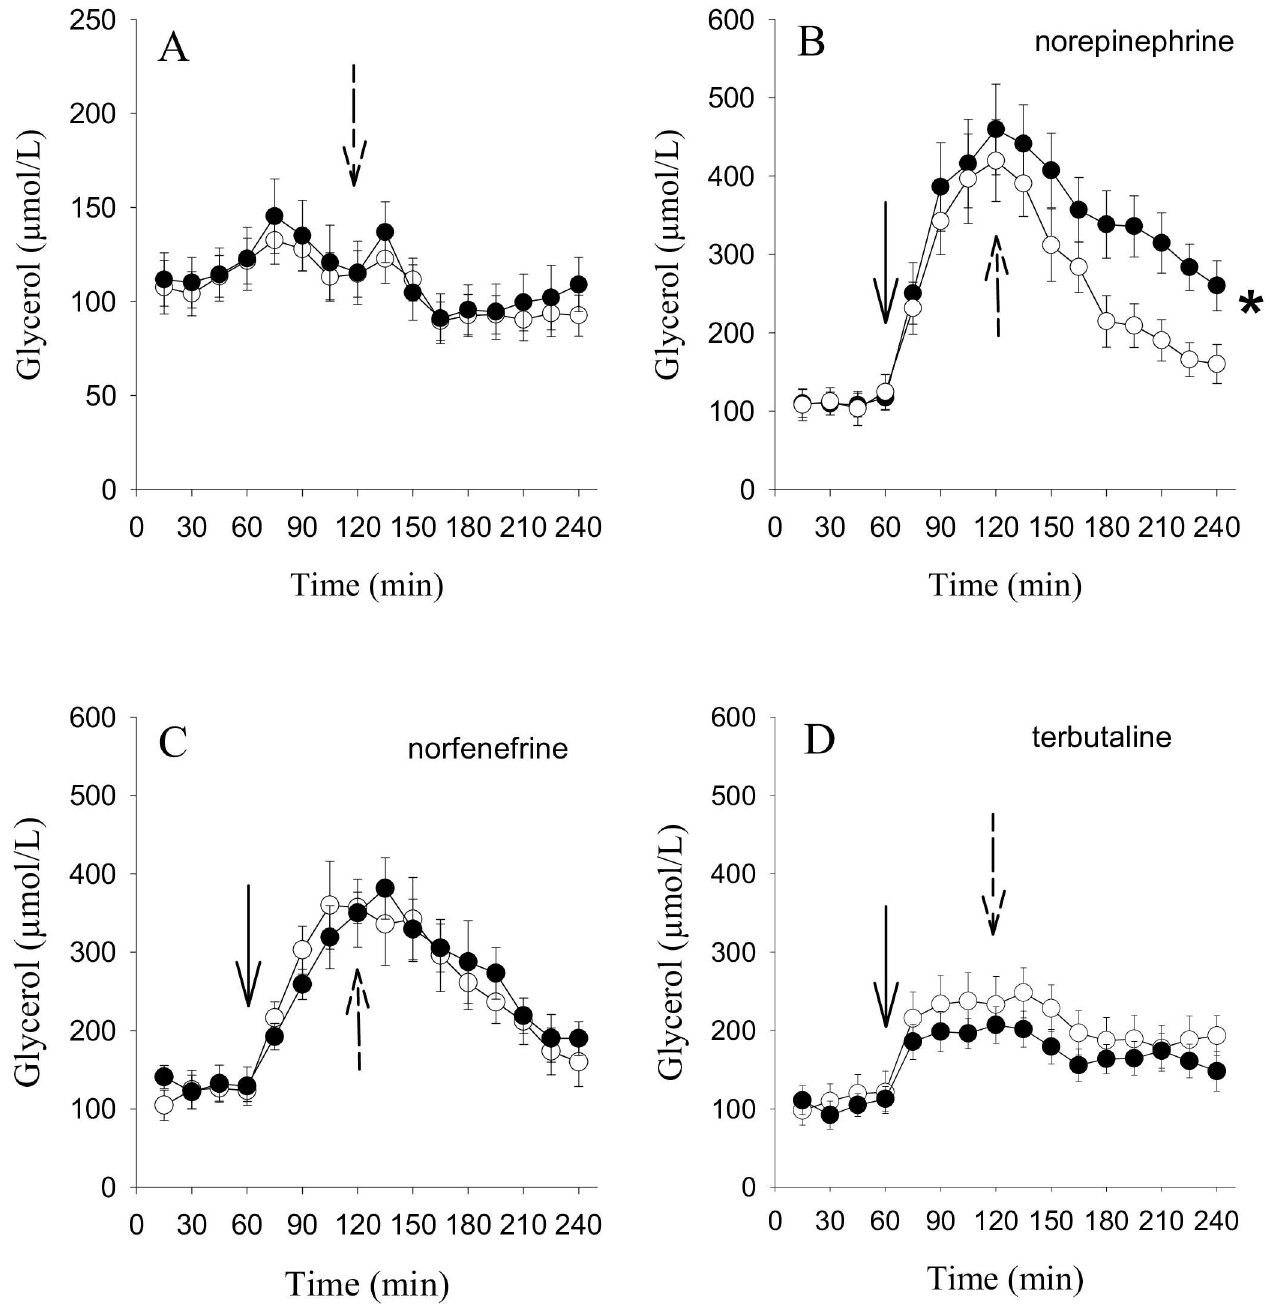
Fig 3. Glycerol microdialysate outflow in adipose tissue in response to adrenergic stimulation and after an iv-glucose load. Interstitial glycerolconcentration in the abdominal subcutaneous adiposetissue of 14 obese T2D subjects ( ● ) and 14 healthyobese controls ( (cid:14) ). Fig 3A: Perfusion with salineduring the durationof the experiment only. Fig 3B–3D: Perfusion with salinefor 60 minutes. Then norepinephrine (Fig 3B), terbutaline(Fig 3C) or norfenefrine(Fig 3D), respectively, were addedto the perfusate(solid arrow) at 10 − 4 M each. 120 minutes after time 0, an iv- glucoseload was given intravenously (0.5 g/kg lean body mass) (dotted arrow). Data are means ± SEM, * p = 0.024 time 120–240 minutes obese T2D subjects vs.